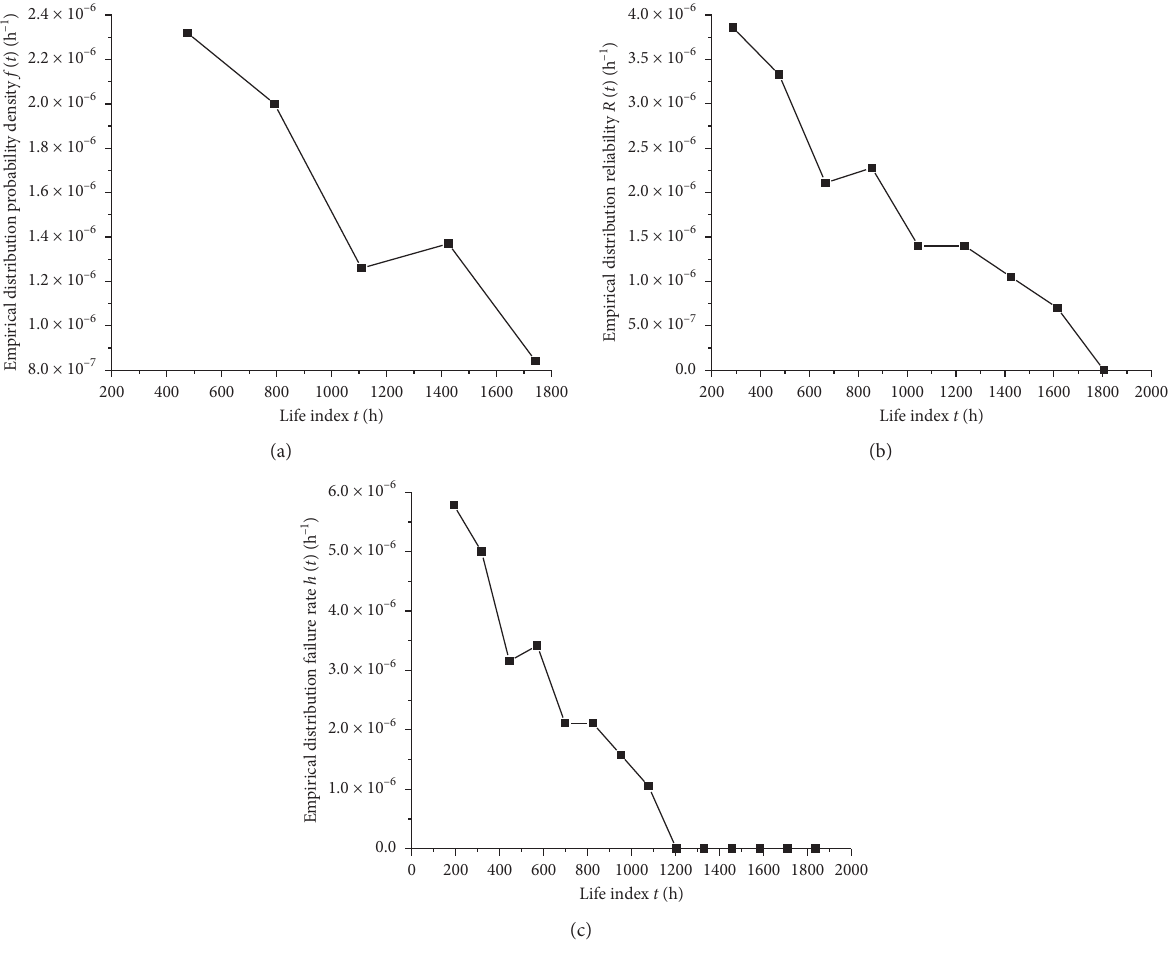
Figure 6: Empirical distribution uncertainty probability density changes with Δ t . (a) Δ t � 316 . 55 ( n � 6). (b) Δ t � 189 . 93 ( n � 10). (c) Δ t � 126 . 62 ( n �